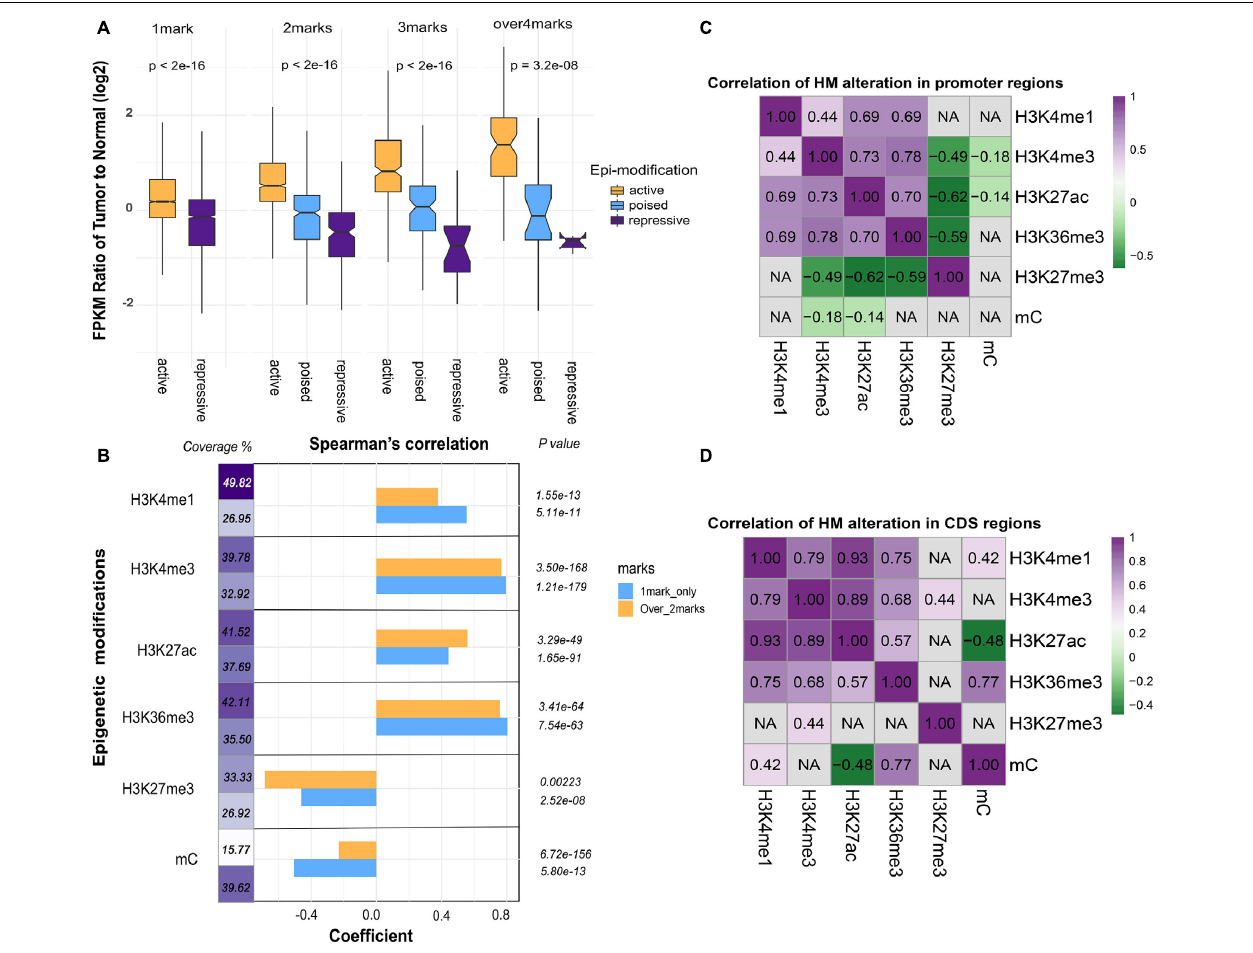
FIGURE 3 | The association between epigenetic modifications and gene expression. (A) Additive effects of epigenetic alterations on gene expression. Genes were grouped into active subgroups (orange), poised subgroups (blue), and repressive subgroups (purple). The X -axis denotes the counts and patterns of epigenetic marks, and the Y -axis shows the log2 FPKM fold change of gene expression. (B) The coefficient of Spearman’s correlation was calculated between epigenetic alterations and fold change of gene expression. Promoters of genes modified by only one epigenetic mark (blue) or more than two marks (orange) were indicated. The coverage denotes the proportion of genes in each category. (C) Pearson’s correlation analysis of paired epigenetic alterations at the promoter and (D) the coding DNA sequence (CDS) ( P < 0.05). Non-significant results were denoted with